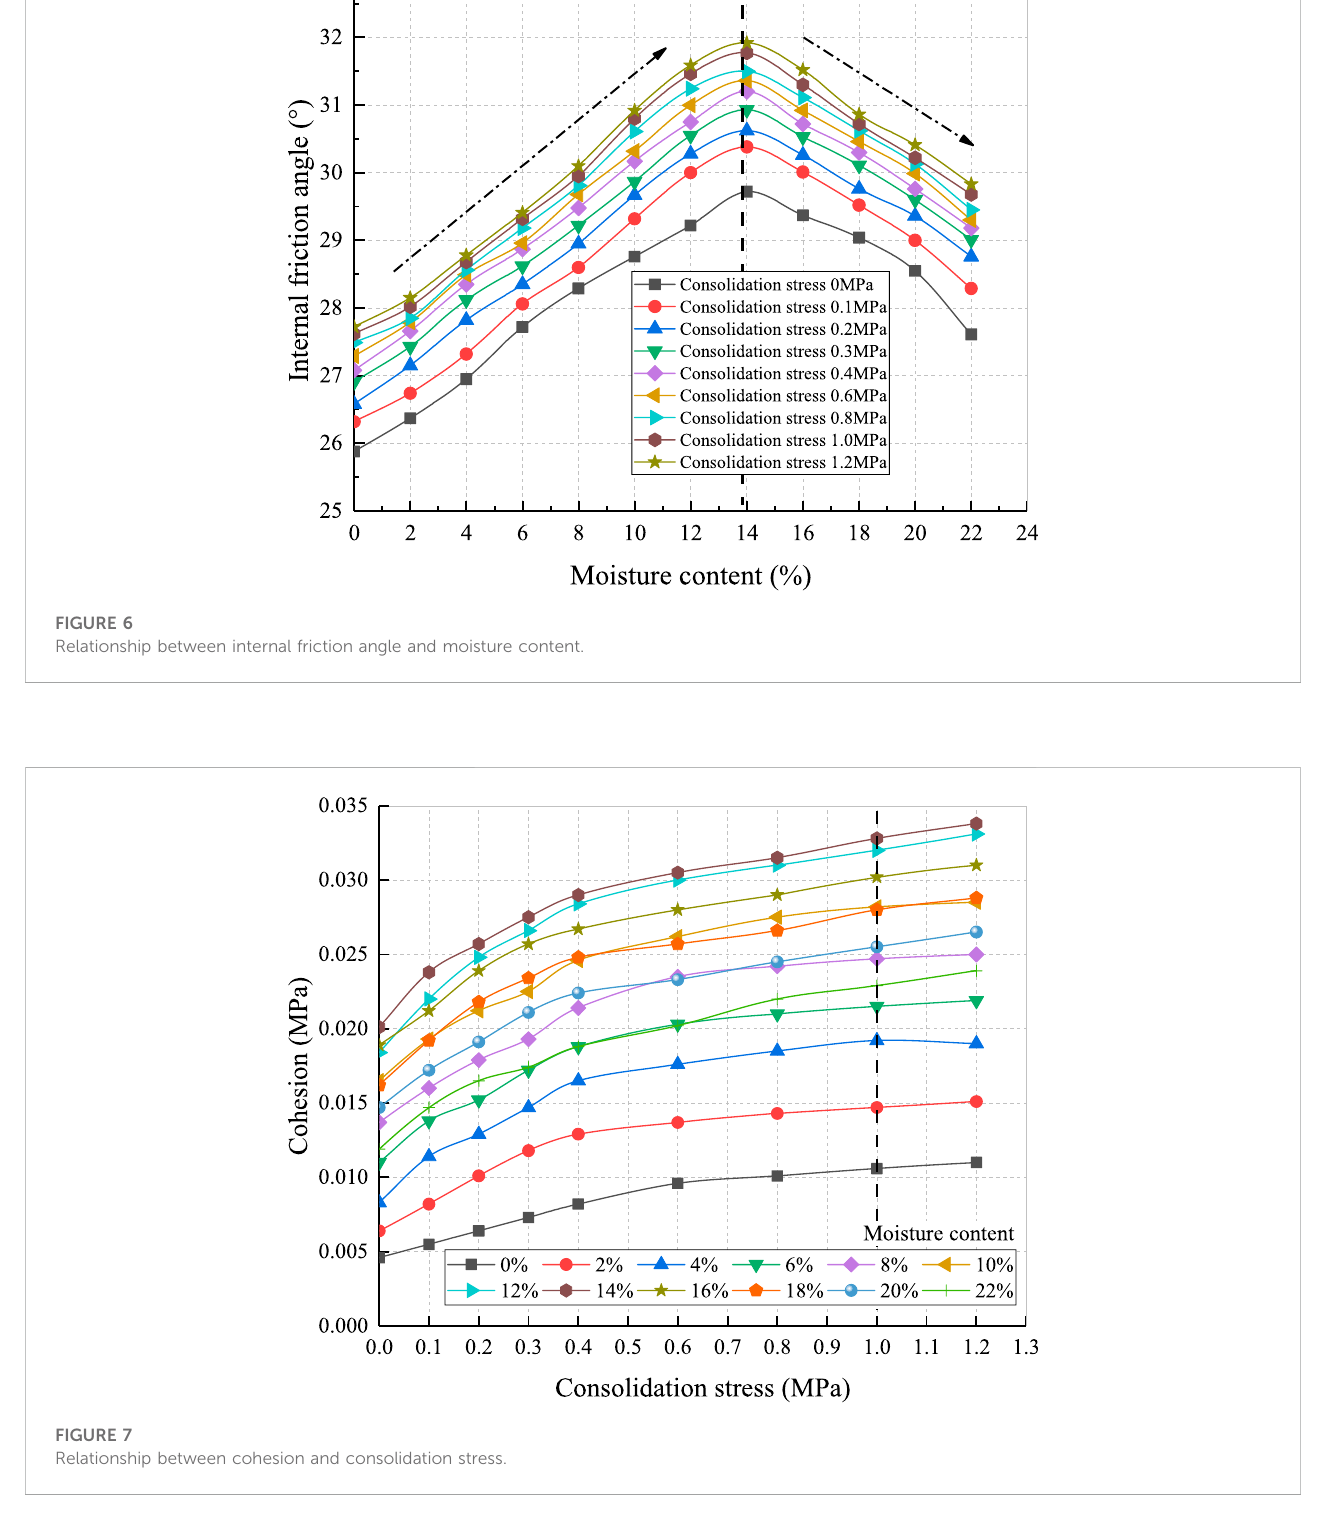
shear strength. When the moisture content was increased even more, including the combined water in the pores, the tailing sand particles were separated by free water, and their ability to withstand shear was weak.